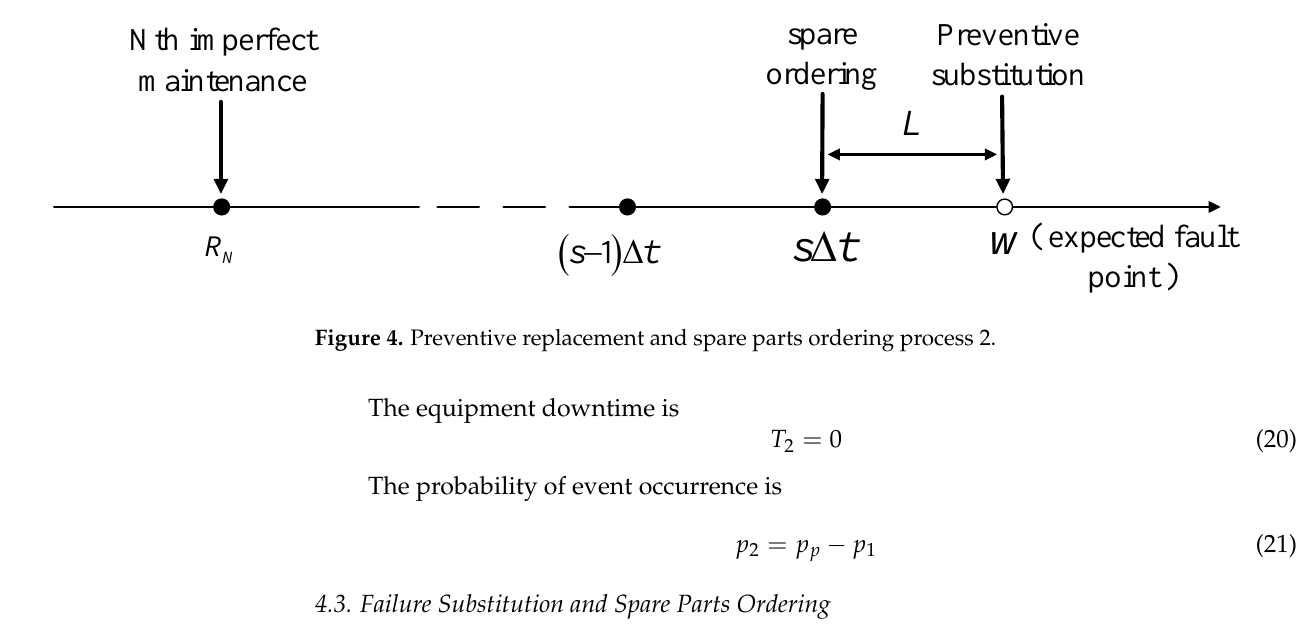
 Figure 3. Preventive replacement and spare parts ordering process 1. The equipment downtime is